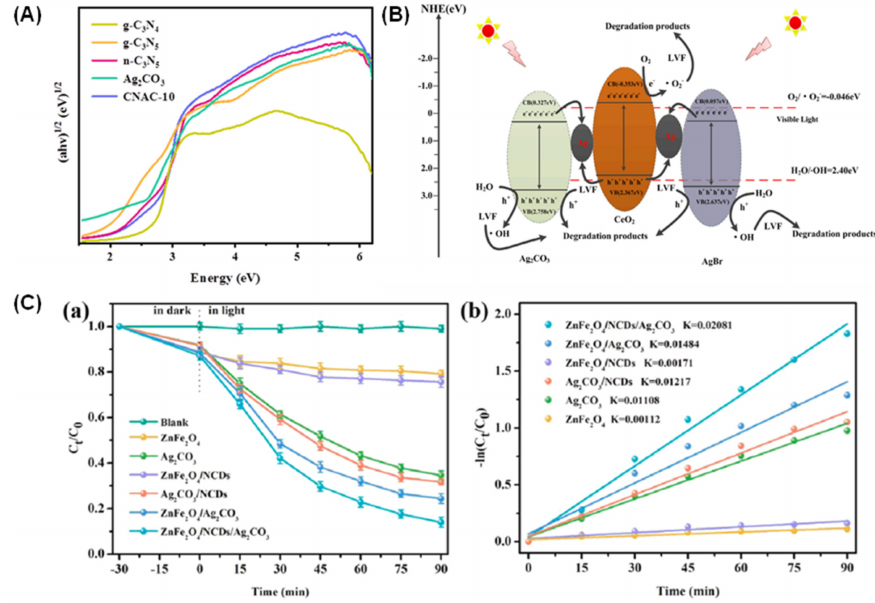
Figure 7. ( A ) Band gap energies of g-C 3 N 4 , g-C 3 N 5 , n-C 3 N 5 , and Ag 2 CO 3 /C 3 N 5 composite. Repro- duced with permission from [86]. ( B ) The proposed mechanism for the enhancement of photocatalytic activity through Z-scheme route. Reproduced with permission from [88]. ( C ) ( a ) Photoactivity for LEV removal under visible light and ( b ) first-order kinetics of as-synthesized photocatalysts. Reproduced with permission from [89].